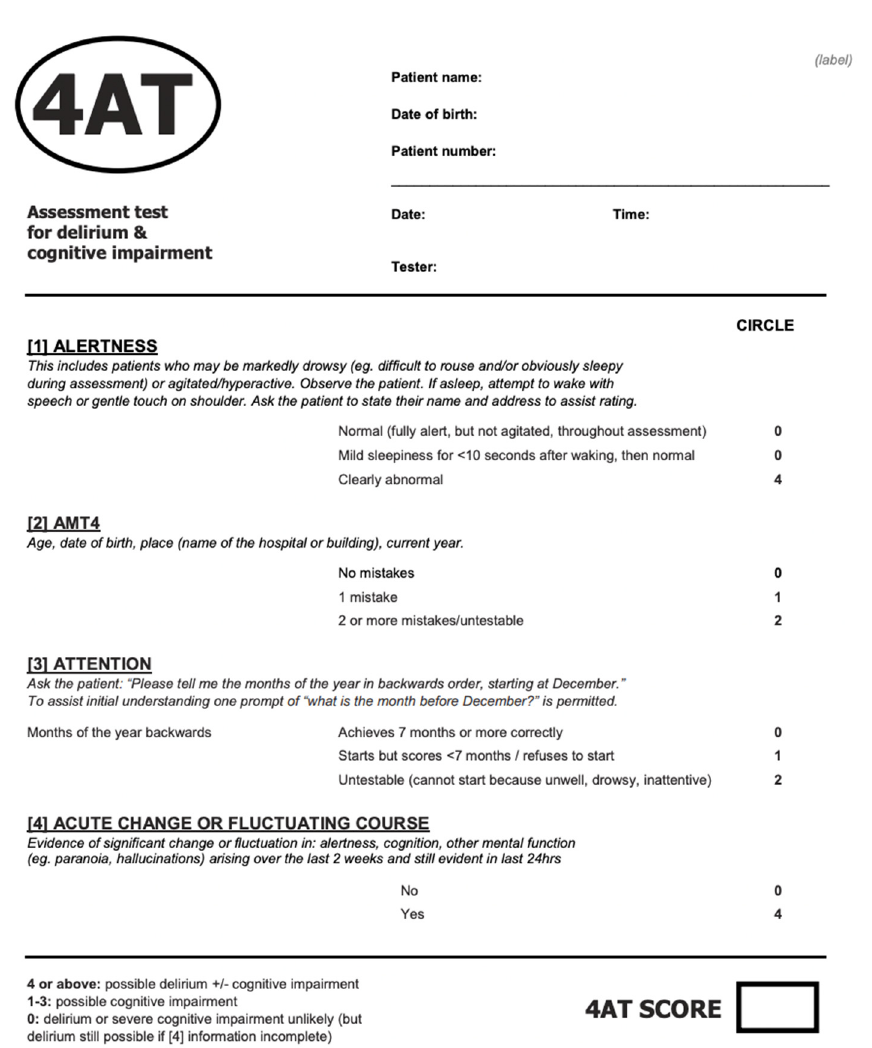
Figure 1. The 4AT scale for the screening of delirium. This scale contains a few simple questions that guide the clinician to define the presence of delirium (for further information, www.the4at.com, accessed on 30 December 2022).